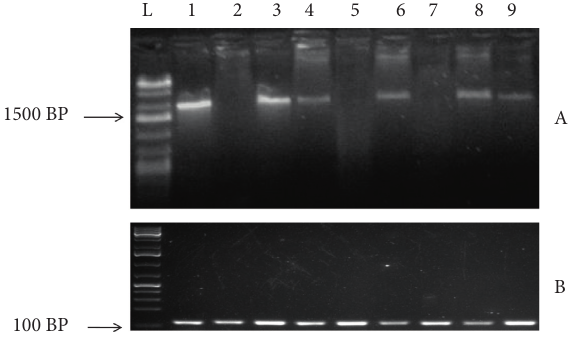
Figure 4: RT- PCR analysis of PCR positive plants. L 1 kb plus gene ruler; 1: positive control; 2: negative control; 3: cDNA from JL